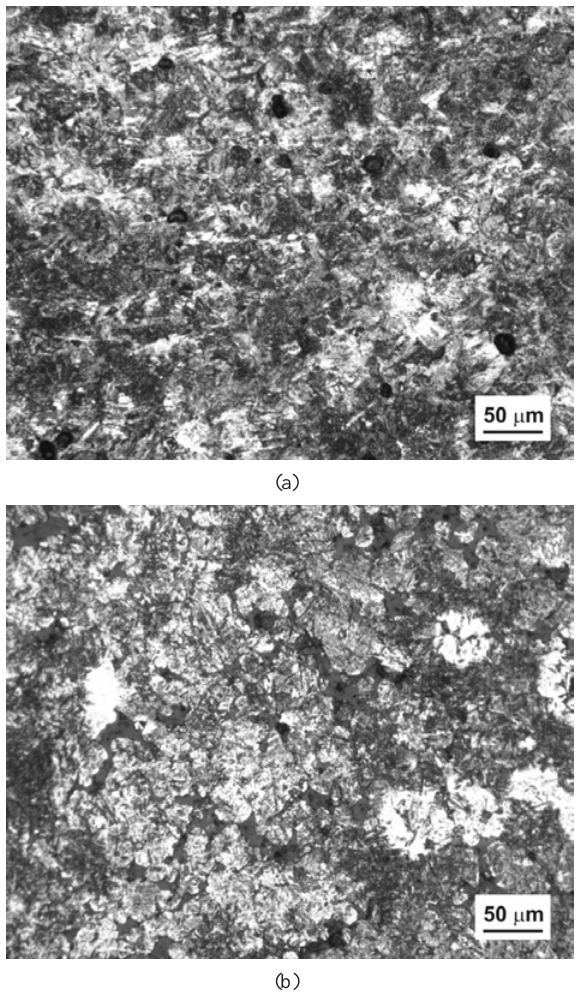
Figure 3. The microstructure cooled at 3 K = s (a) and at 6 K = s (b).